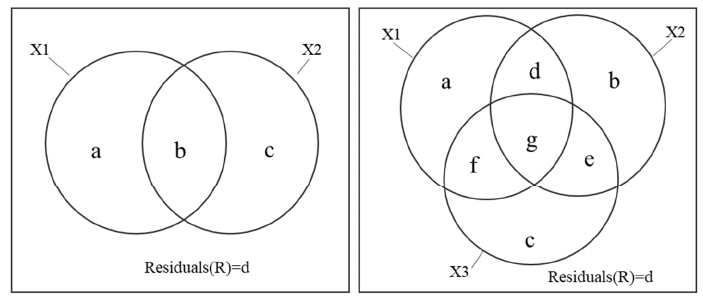
Figure 2. Schematic diagram of the variance decomposition of two and three categories of variables.